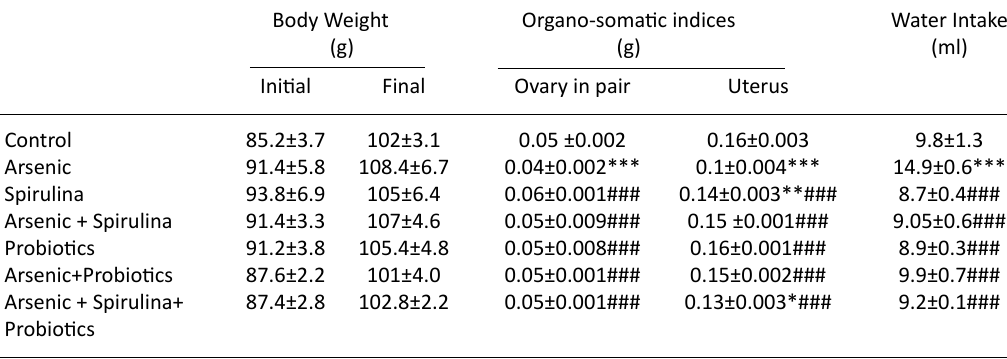
Table 1. Body weight and organo-somatic indices (female reproductive